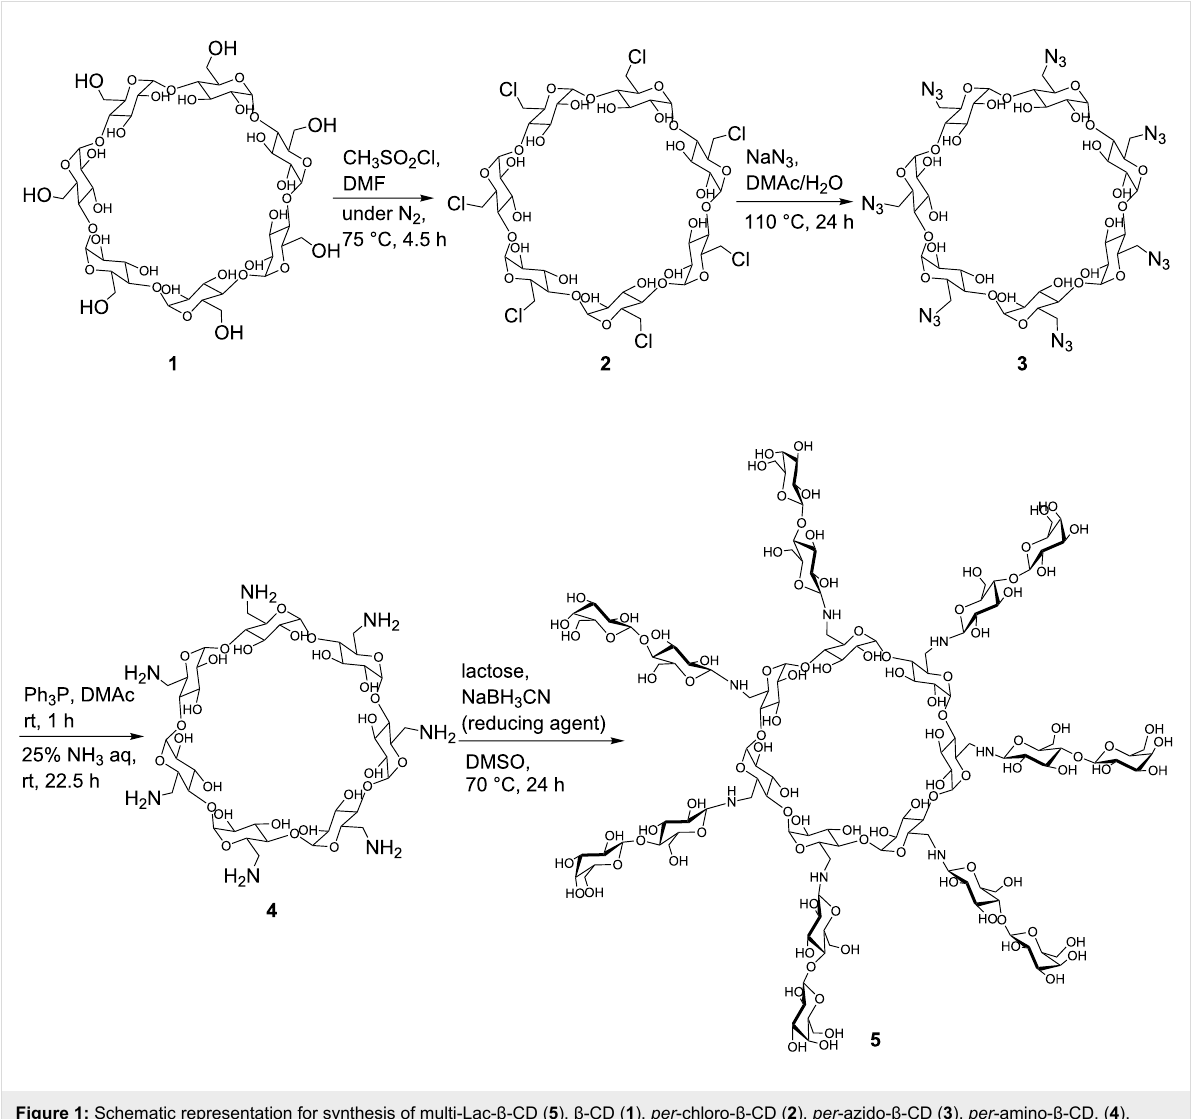
Interaction between multi-Lac- β -CD